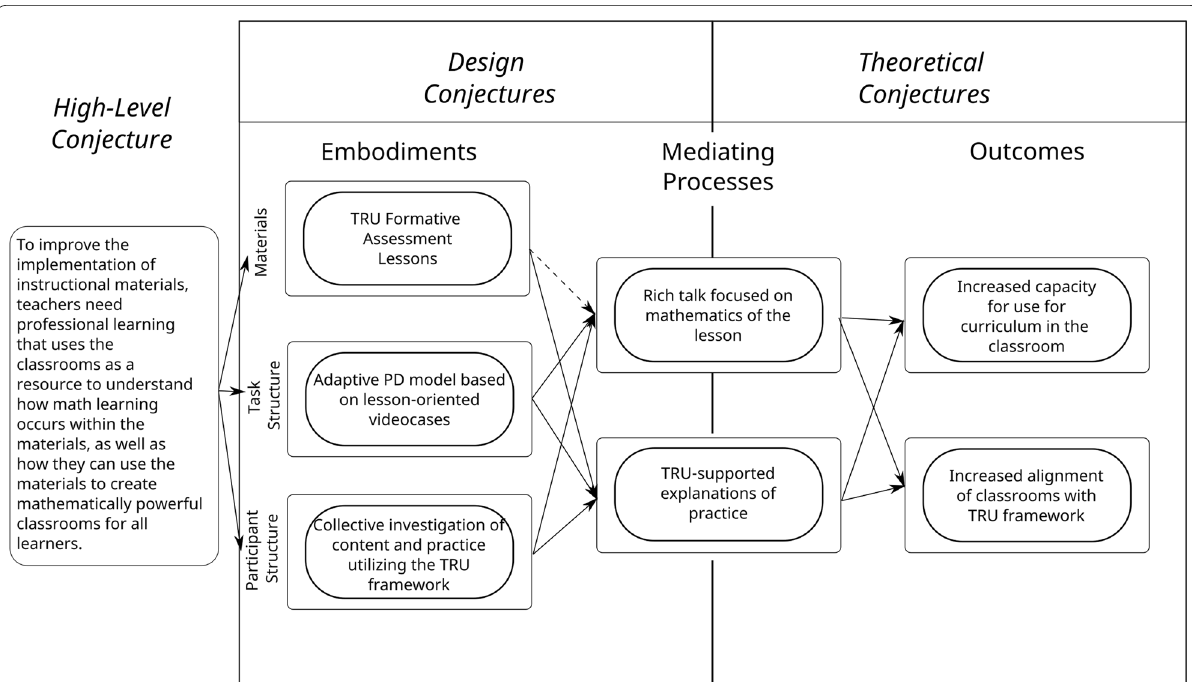
Fig. 1 Conjecture map that guided our early RPP